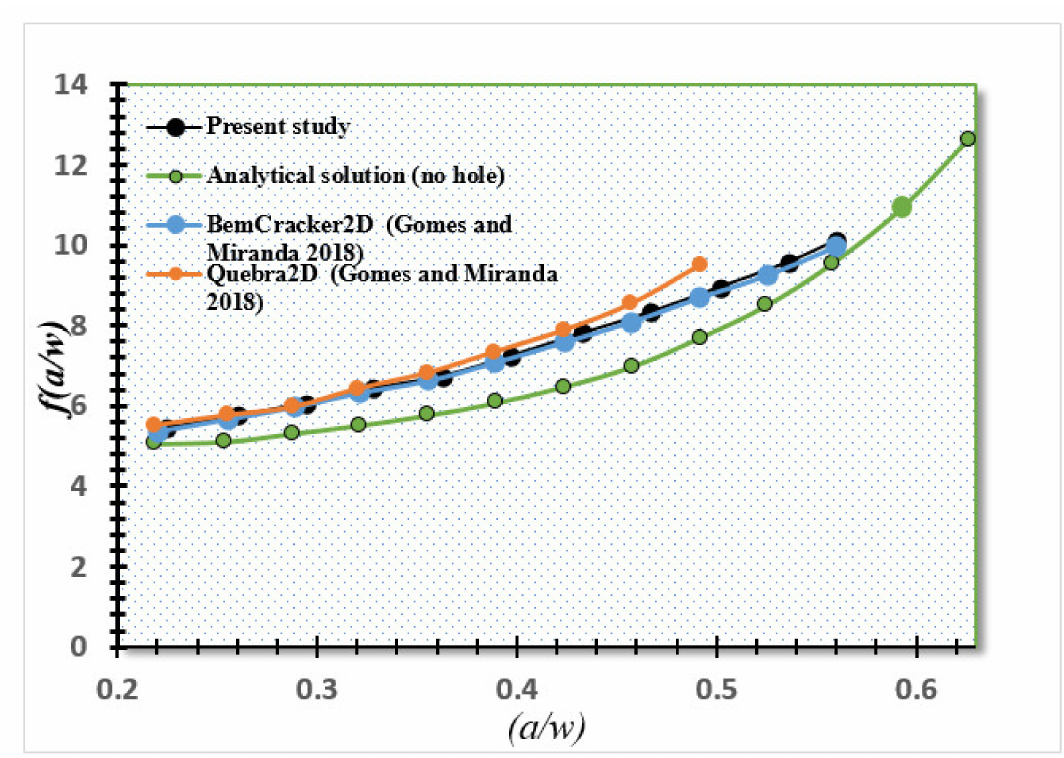
Figure 12. Dimensionless SIFs of CTS02 compared to the analytical solution and the work of [41].